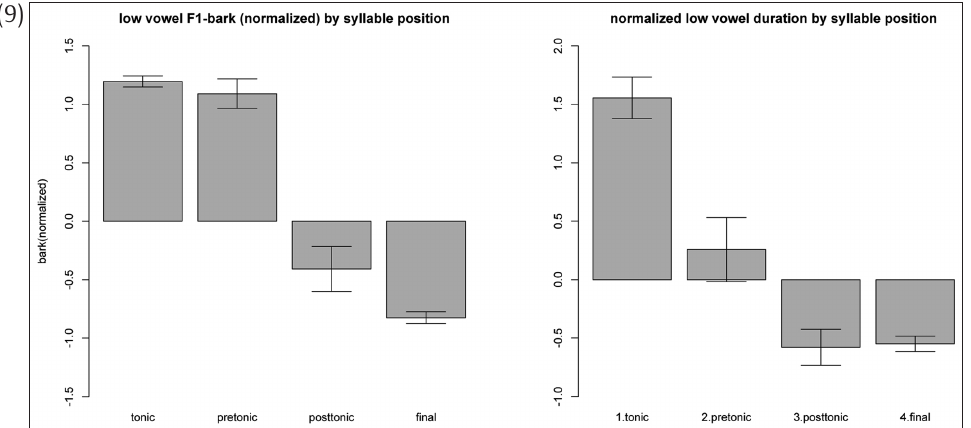
Figure 3: Mean F1 and duration measures of the low vowel nucleus in the four syllable positions from set A. Error bars are 95% confidence